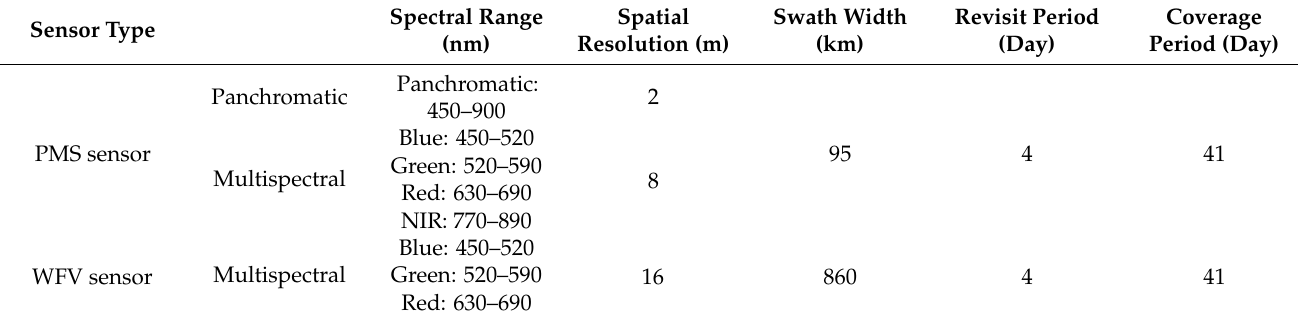
Table 1. Indicators of GF-6 satellite payload and